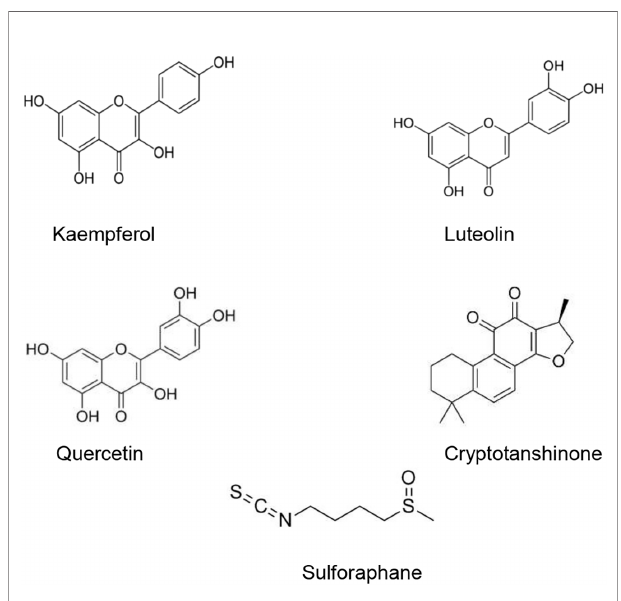
FIGURE 3 | Natural products that act as inhibitors of TMPRSS2.